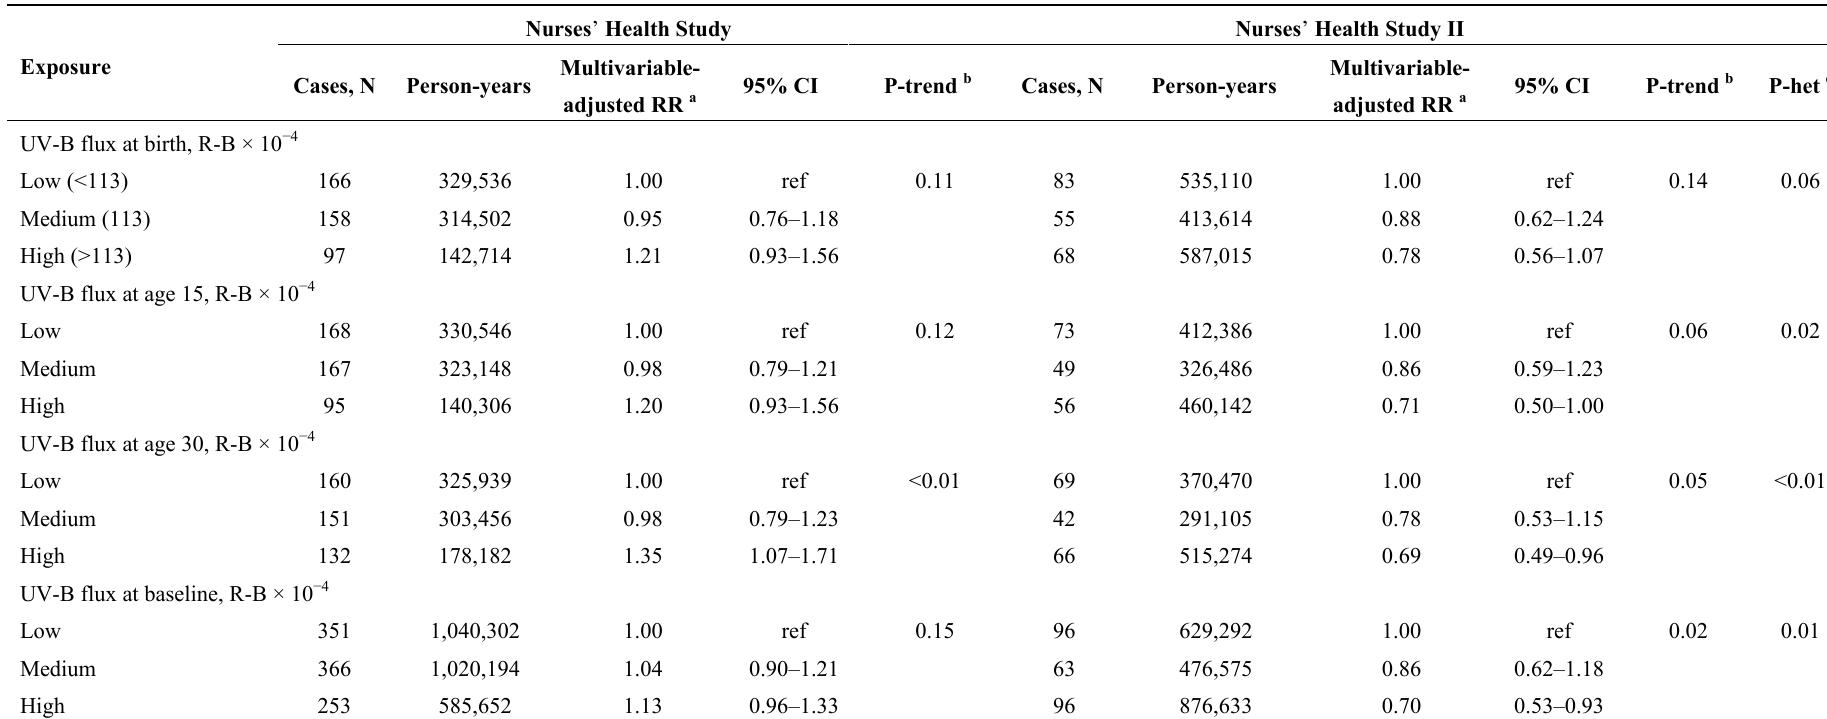
Table 2. Associations between surrogates of vitamin D exposure and epithelial ovarian cancer risk in the NHS and NHS